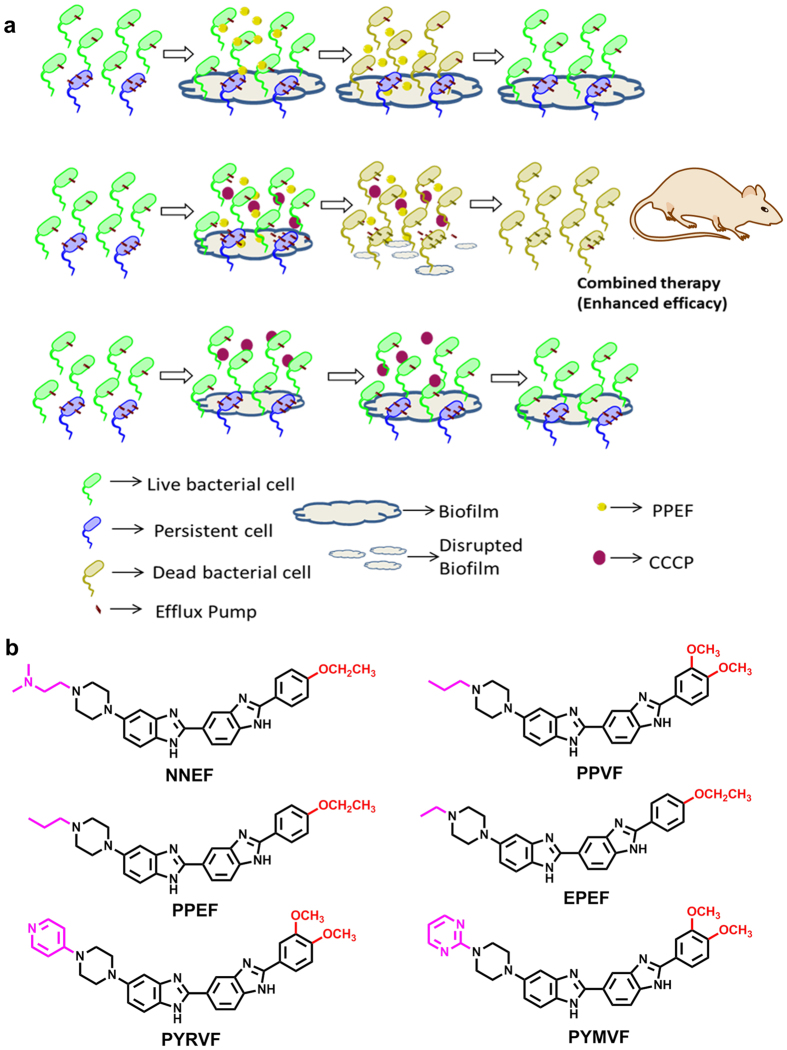
(a) Schematic presentation of enhanced antibacterial activity and efficacy by PPEF and CCCP combination therapy. (b) Chemical structures of Bisbenzimidazoles.